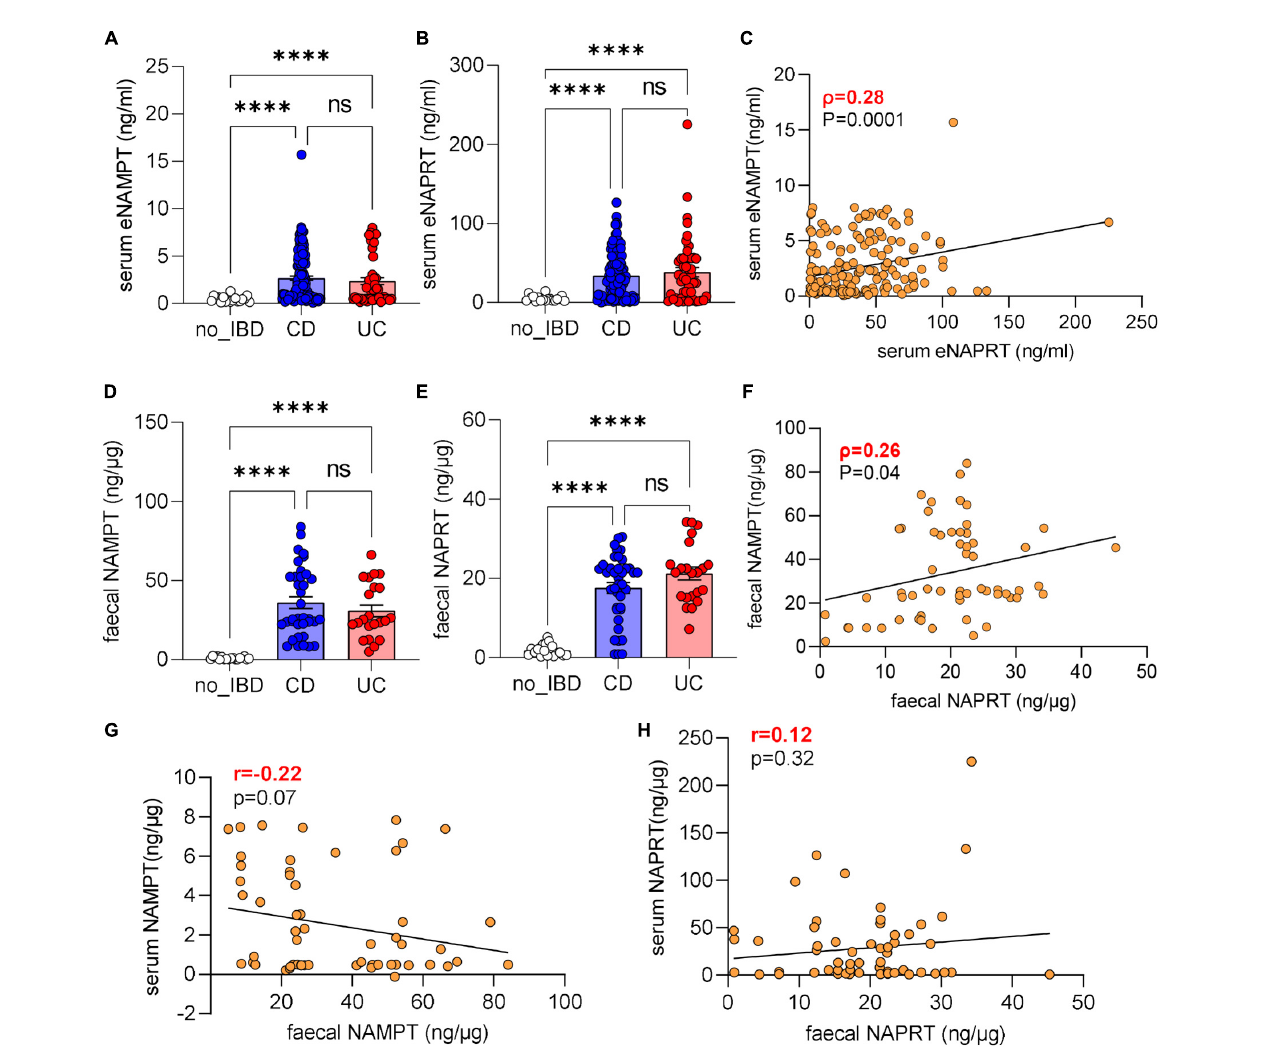
FIGURE1 eNAMPT and eNAPRT are increased in serum and faces of IBD patients. (A) Serum eNAMPT levels and (B) eNAPRT levels (healthy controls N = 18: CD n = 128; UC = 52). (C) Pearson correlation between serum eNAMPT and eNAPRT levels in IBD patients. (D) Faucal NAMPT and (E) NAPRT levels (healthy controls N = 18: CD n = 40; UC = 22). (F) Pearson correlation between faucal NAMPT and faucal NAPRT levels in IBD patients. (G) Pearson correlation between faucal NAMPT and serum eNAMPT levels in IBD patients. (H) Pearson correlation between faucal NAPRT and serum eNAPRT levels in IBD patients. P -value: ∗∗∗∗ p <